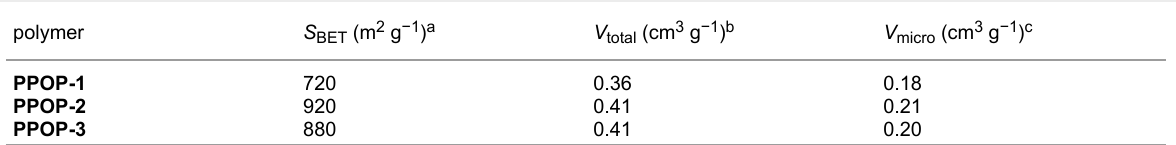
Table 1: Porosity properties of PPOP-1 – PPOP-3 .